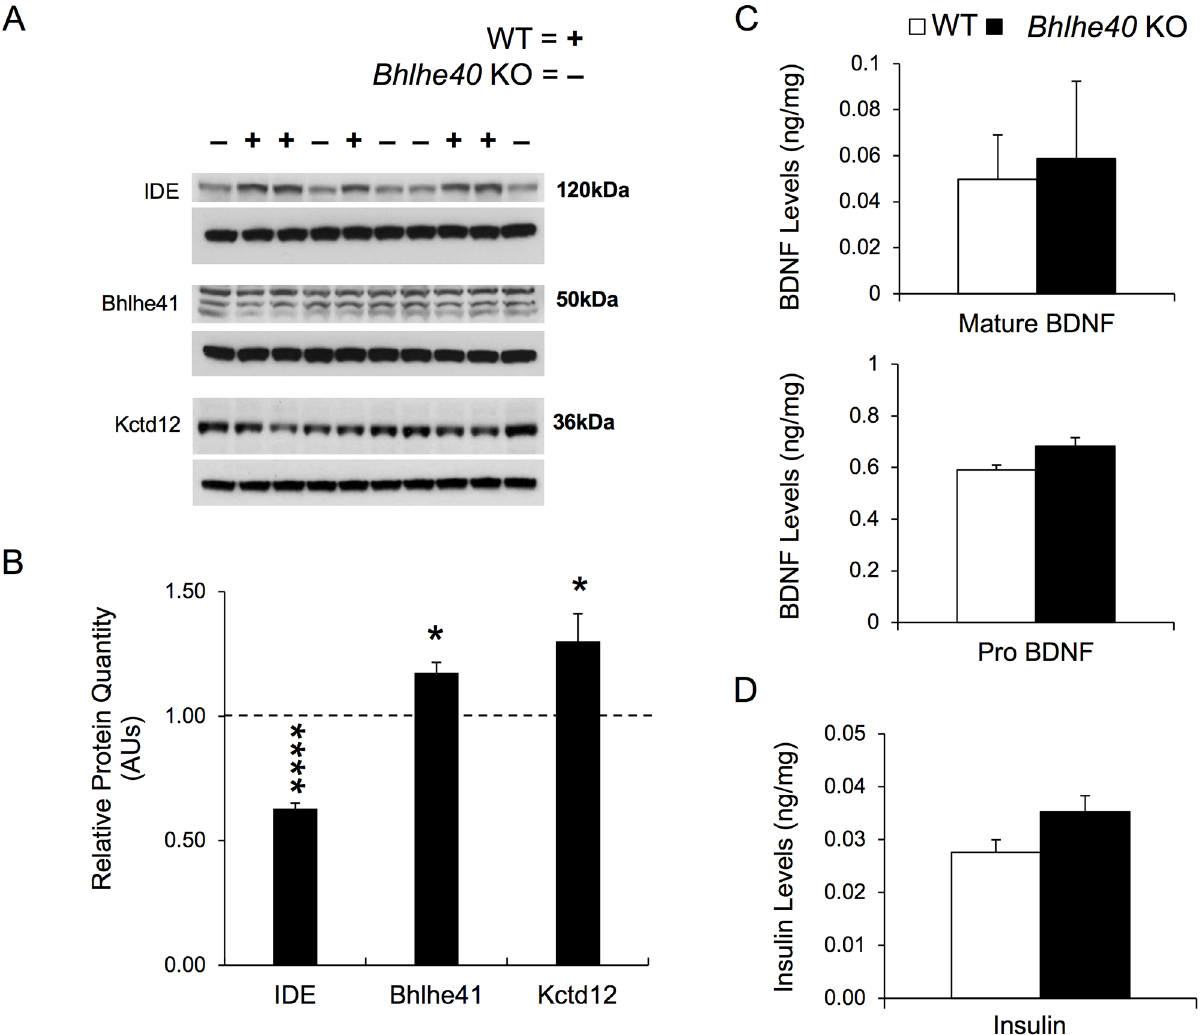
Fig 7. Insulin levels trended to an increase but are not changed in the hippocampus of Bhlhe40 KO mice. (A) Protein (Western) Blots were used to determine expression levels of proteins for candidate genes identified from the mRNA validation experiments. Single hippocampi from six WT and Bhlhe40 KO mice were used for protein-level analysis by western blotting. Representative autoradiograms from WT (+) and Bhlhe40 KO (-) samples are shown for IDE (120kDa), Bhlhe41(50kDa), and Kctd12 (36kDa). (B) Protein quantification by western blot was determined via densitometry using Fiji (Image J). In Bhlhe40 KO hippocampus, IDE was 1.6-fold downregulated (p < 0.0001), Kctd12 was 30% upregulated (p < 0.05), and Bhlhe41 was 18% upregulated (p < 0.05) relative to WT levels. For Bhlhe41, a triplet band was observed, likely due to the two possible post translation sumoylations. The relative expression for Bhlhe41 represents a combination of all three bands. Unpaired t-tests were used to test for significance changes for protein levels. Values shown are Bhlhe40 KO protein level relative to WT levels by arbitrary units (AUs); (cid:3) = p < 0.05 (cid:3)(cid:3)(cid:3)(cid:3) = p < 0.0001. Additionally, Clock, Camk1d, Gabbr1, GluR1, Scn1a, and Chl1 were tested and found to be not significantly changed in Bhlhe40 KO hippocampus. (C) Single hippocampi from six WT and Bhlhe40 KO mice were used for BDNF quantification by ELISA. Mature BDNF (top) and Pro BDNF (bottom) were tested on independent ELISAs. BDNF levels are expressed in ng of BDNF relative to mg of total protein. Top) pro BDNF (unpaired t-test p > 0.05); Bottom) mature BDNF (unpaired t-test p > 0.05). (D) Single hippocampi from seven WT and Bhlhe40 KO mice were used for insulin quantification by ELISA. Insulin levels are expressed in ng of insulin relative to mg of total protein (insulin ELISA students t-test p = 0.07). All error bars are standard error of the